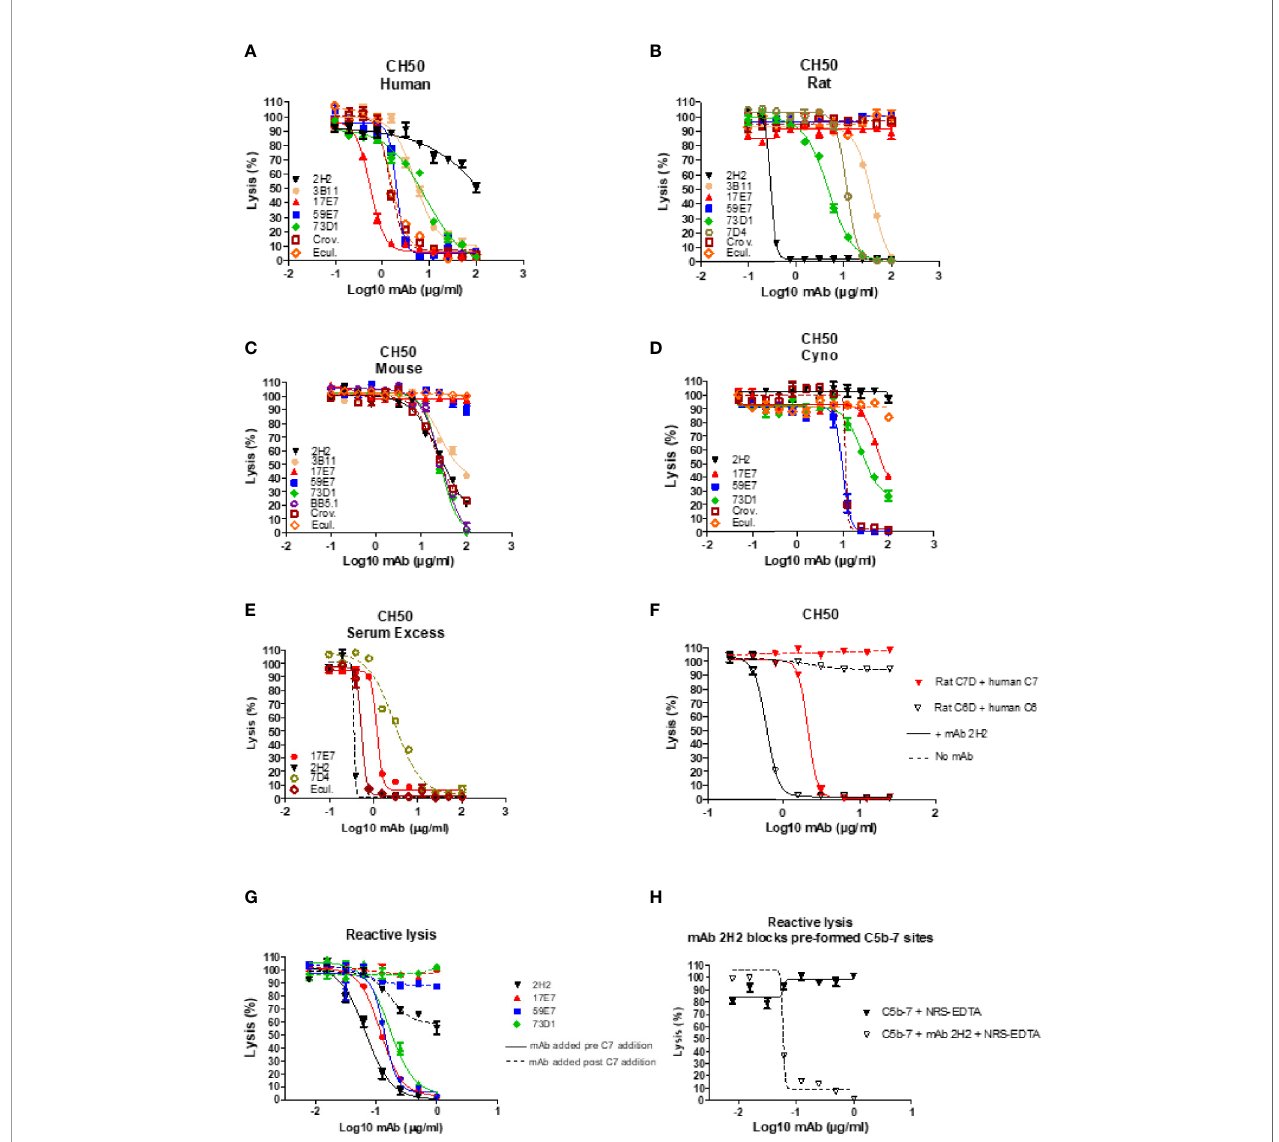
FIGURE 1 | Functional assays of C7-blocking mAbs. (A – D) Anti-C7 mAb were tested for blocking activity in classical pathway (CP) hemolysis (CH50) assays across species. Sera tested were human (A) , rat (B) , mouse (C) and cynomolgus monkey (Cyno) (D) . Anti-C5 mAb crovalimab (Crov), eculizumab (Ecul), BB5.1 and 7D4 were used as comparators. Test and control mAb were titrated in range 0 – 100 µg/ml. (E) Serum excess assay using NHS or NRS concentration 10-fold that used in the standard CP assay; solid lines are NHS, dashed lines are NRS. (F) human C6D and C7D were reconstituted with puri fi ed human C6 or C7 (dashed lines) respectively and the capacity of mAb 2H2 to inhibit hemolysis tested. (G, H) Reactive lysis assays using guinea pig erythrocytes (GpE) as target; for mAb 17E7, 59E7, and 73D1, puri fi ed human complement proteins (C5b6, C7, C8 and C9) were used; for mAb 2H2 and 73D1 human C5b6 and rat C7 were used with normal rat serum (NRS) as the source of rodent C8 and C9. The mAb were either added to GpE-C5b6 before or after C7 addition (G) ; solid and dotted line respectively. mAb 2H2 was added to washed GPE- C5b-7 (rat) prior to addition of NRS as source of C8 and C9 (H) . All experiments were repeated three times with the same results. The error bars are standard errors of